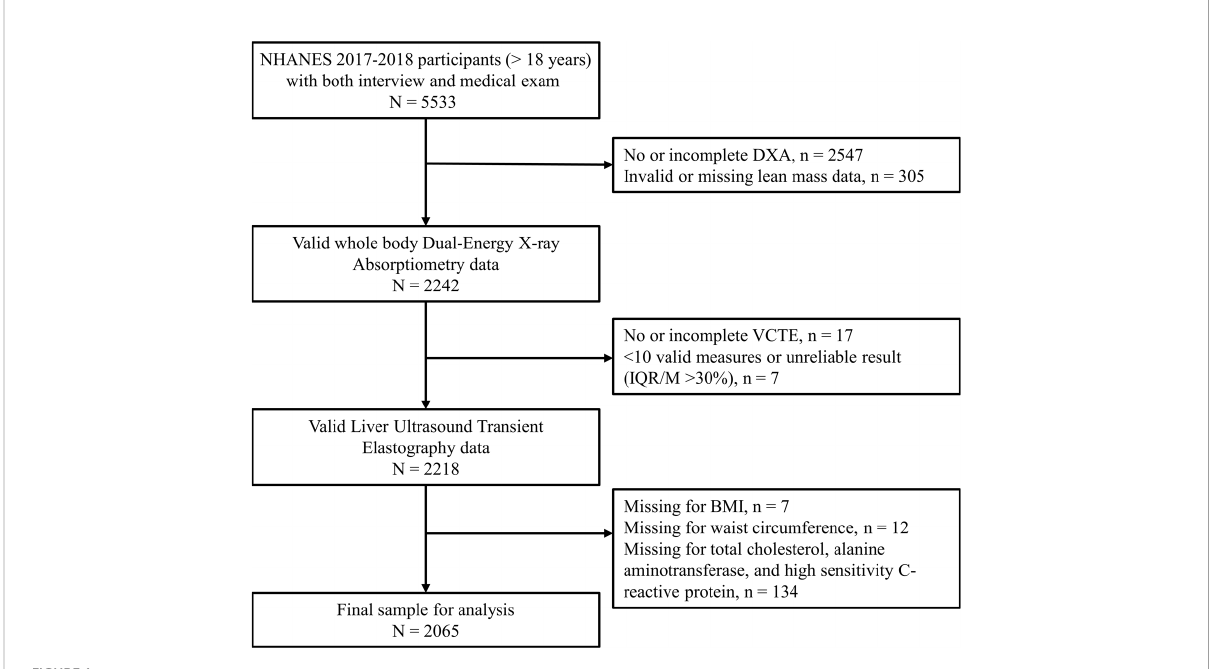
FIGURE 1 Flow diagram of the analytic